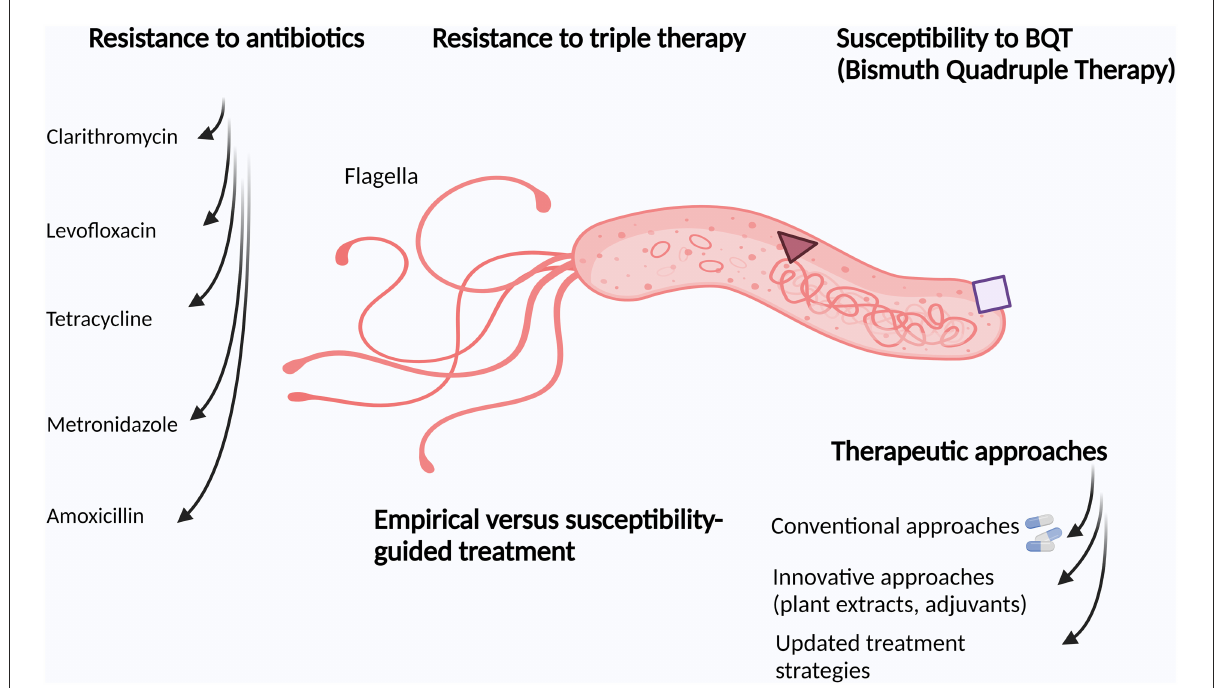
FIGURE1 Overview of different features of Helicobacter pylori